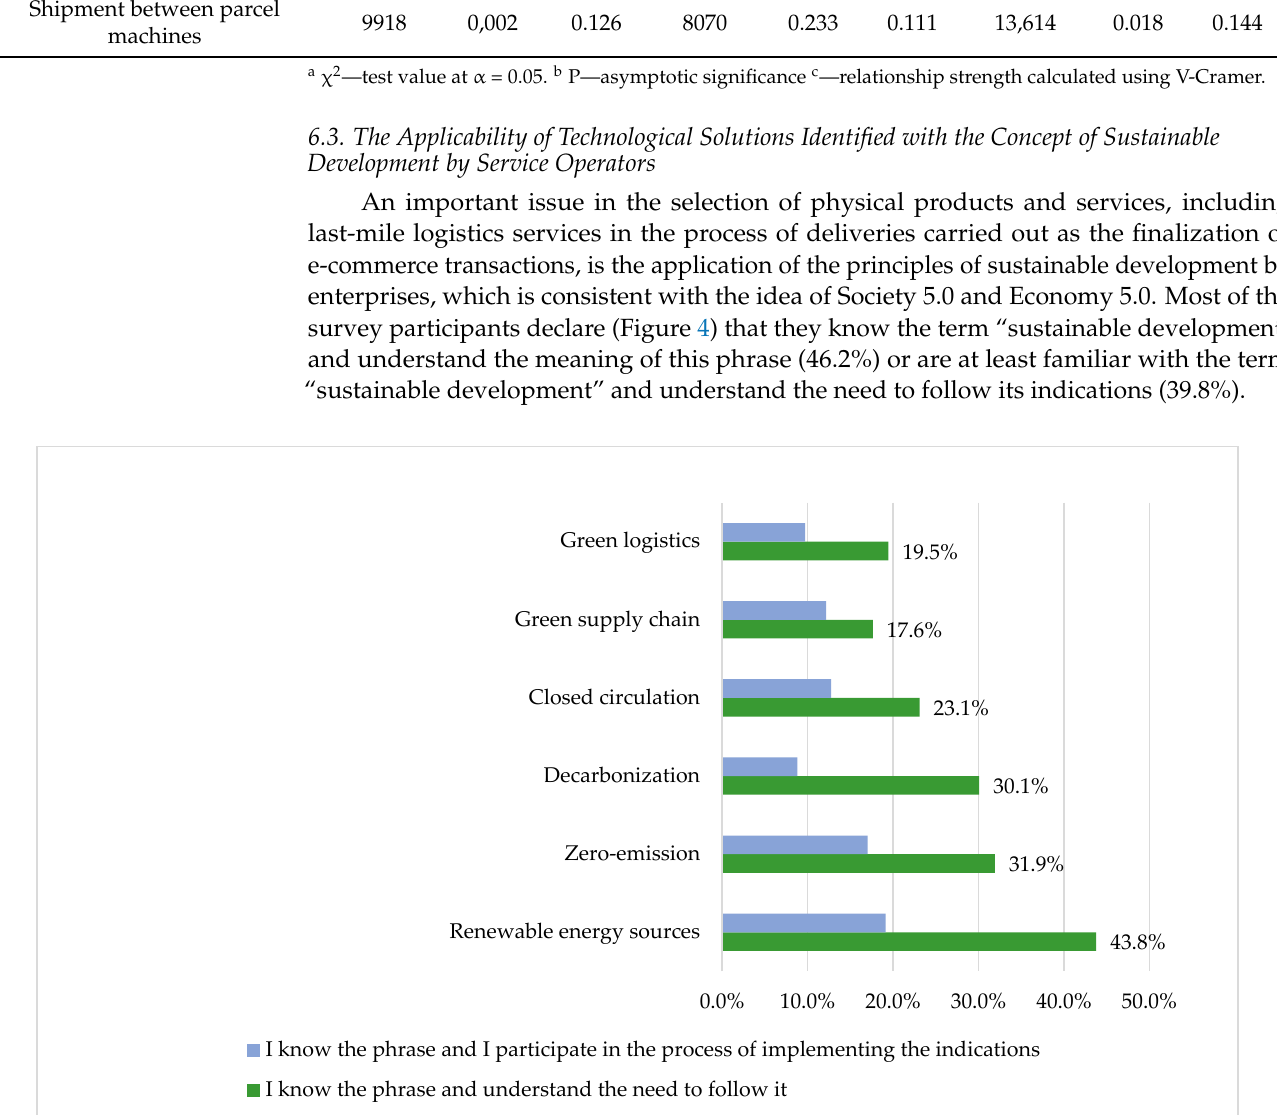
Figure 4. Traceability of the meaning of the term “sustainable development”.